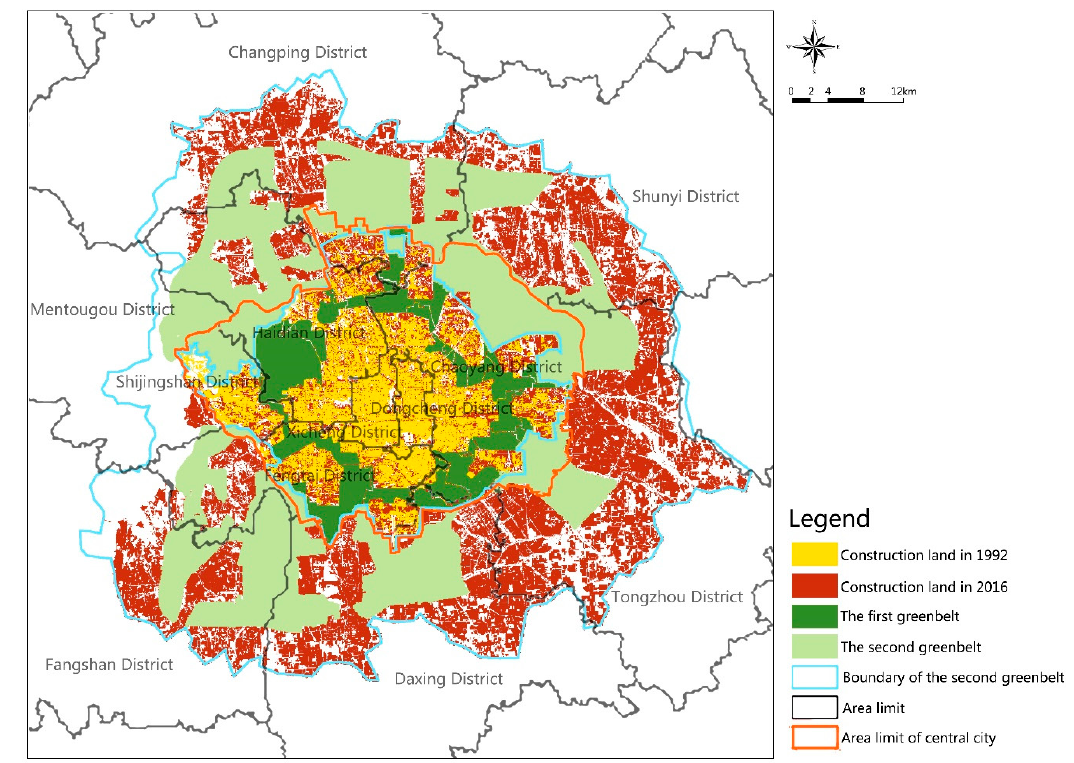
Figure 1. The spatial distribution of urbanization and greenbelt in central Beijing.